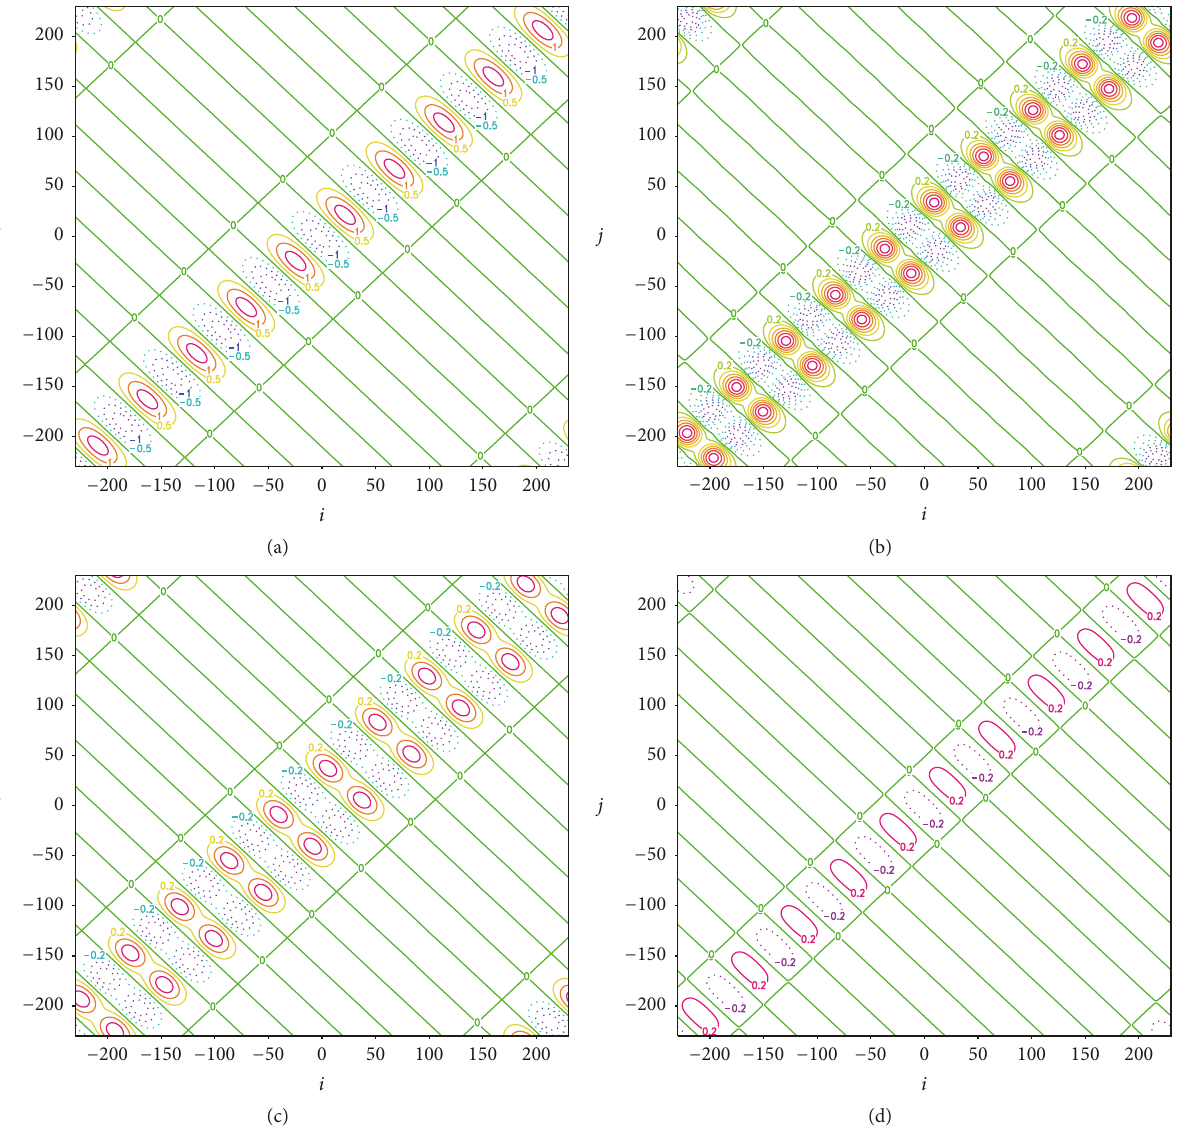
Figure 4: (a) Deviation of A 𝑒 from benchmark A in Figure 3 plotted by color contours every 0.5 m 2 s −2 . Deviations of A 𝑎 , A 𝑏 , and A 𝑐 from benchmark A are plotted by color contours every 0.2 m 2 s −2 in panels (b), (c), and (d), respectively. Here, A 𝑒 is the previously estimated analysis error covariance matrix with its 𝑖𝑗 th element 𝐴 𝑒𝑖𝑗 ≡ 𝜎 2 𝑒 𝐶 𝑎 (𝑥 𝑖 −𝑥 𝑗 ) obtained from the spectral formulation, while A 𝑎 , A 𝑏 , and A 𝑐 are the newly modified estimates of A as shown in (8a), (8b), and (8c),